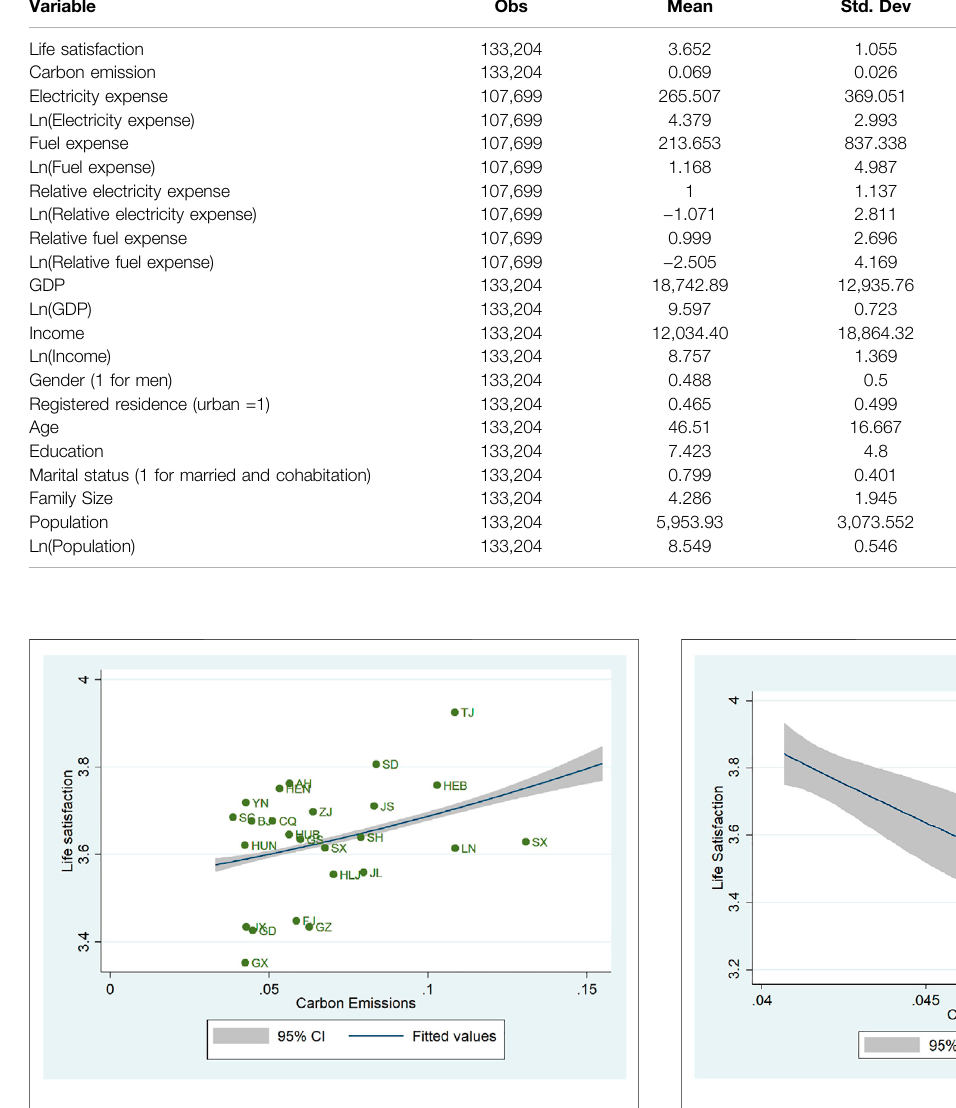
FIGURE 1 | The relationship between carbon emissions and life satisfaction. Notes: Quadratic fi t is shown with 95% con fi dence intervals. All data are averaged over the 2010 – 2018 period.